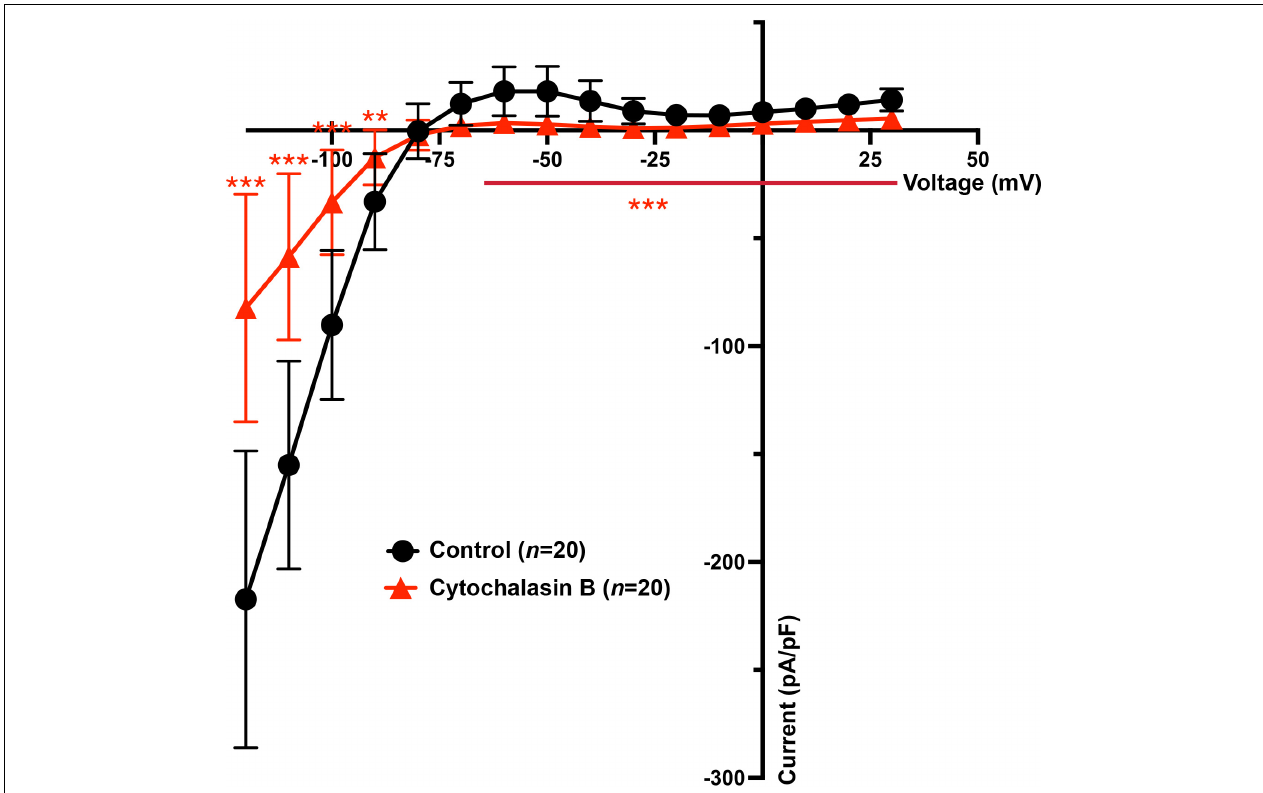
FIGURE 4 | Cytochalasin B treatment decreases both inward and outward I KIR 2 . 1 in HEK-KWGF cells. Current-voltage relationship of mean I KIR 2 . 1 current values ± SD. In the treatment group, cells were treated with Cytochalasin B for 24 h with a final concentration of 20 µ M. The control group did not undergo any treatment. n = 20 cells for each group. ** p < 0.01, *** p <